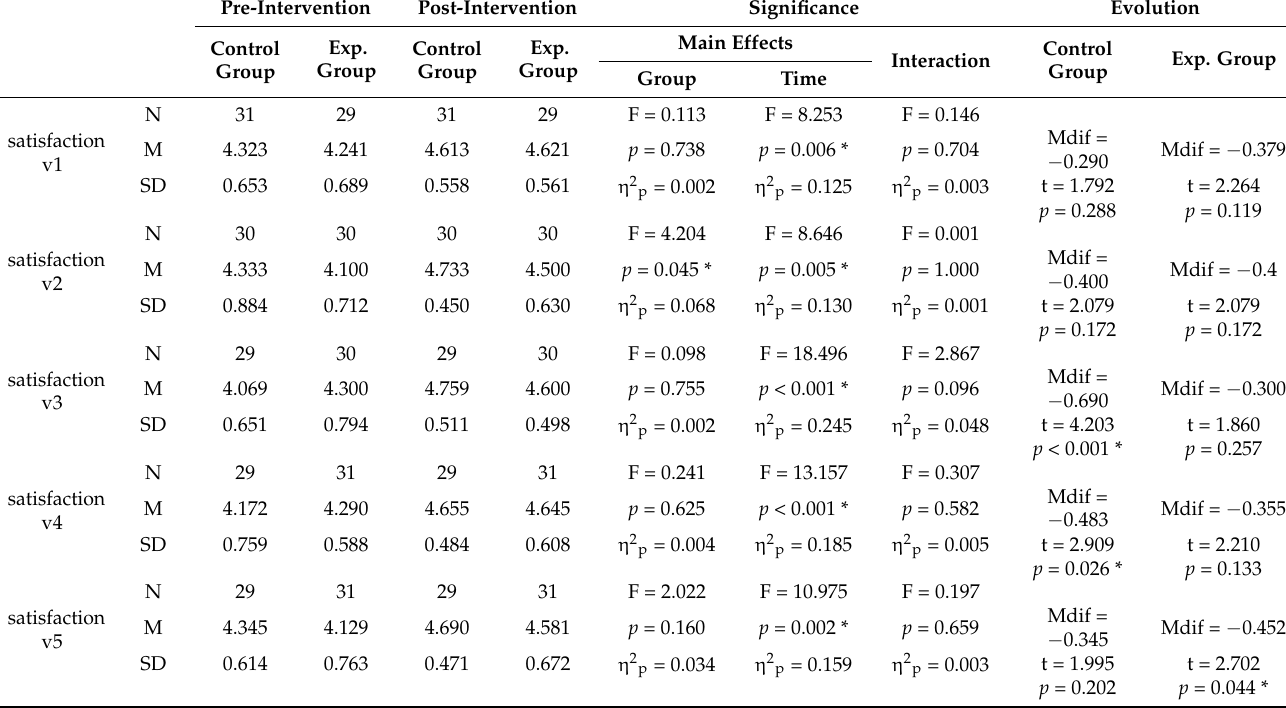
Main Effects Exp. Group